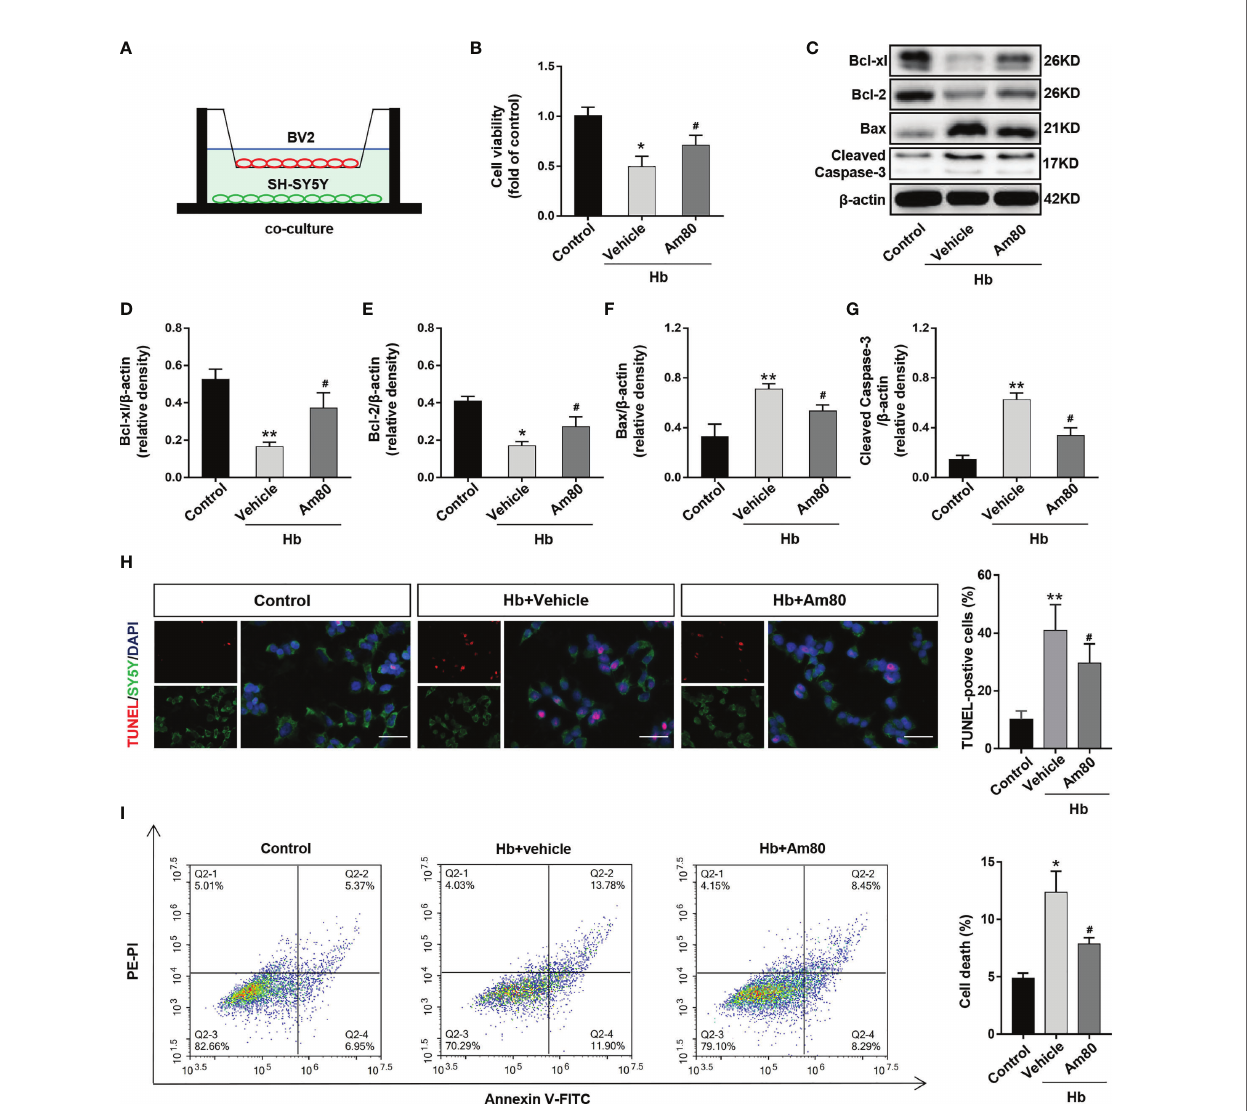
FIGURE 4 | Am80 attenuated neuronal apoptosis in vitro SAH model. (A) Illustration of the co-culture system. (B) Quantitative analyses of cell viability as detected by CCK8 assays. n=3 per group. (C – G) Western blotting and quantitative analyses of the expression of Bcl-xl, Bcl-2, Bax, and cleaved-caspase 3 of SH-SY5Y after co-cultivation. n=3 per group. (H) Immuno fl uorescence staining of TUNEL (red) and SH-SY5Y (green) in an in vitro co-culture system. Scale bar=50 m m. n=3 per group. (I) Representative fl ow cytometry images of SH-SY5Y cells, the necroptosis is represented by the ratio of PI +/annexin V+. n=3 per group. * P < 0.05 vs control group; ** P < 0.01 vs control group; # P < 0.05 vs Hb+vehicle